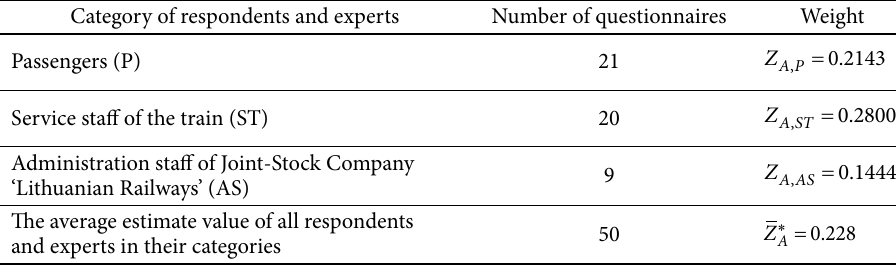
Table 1. The significance (weight) of the criteria of group A describing travel by train Category of respondents and